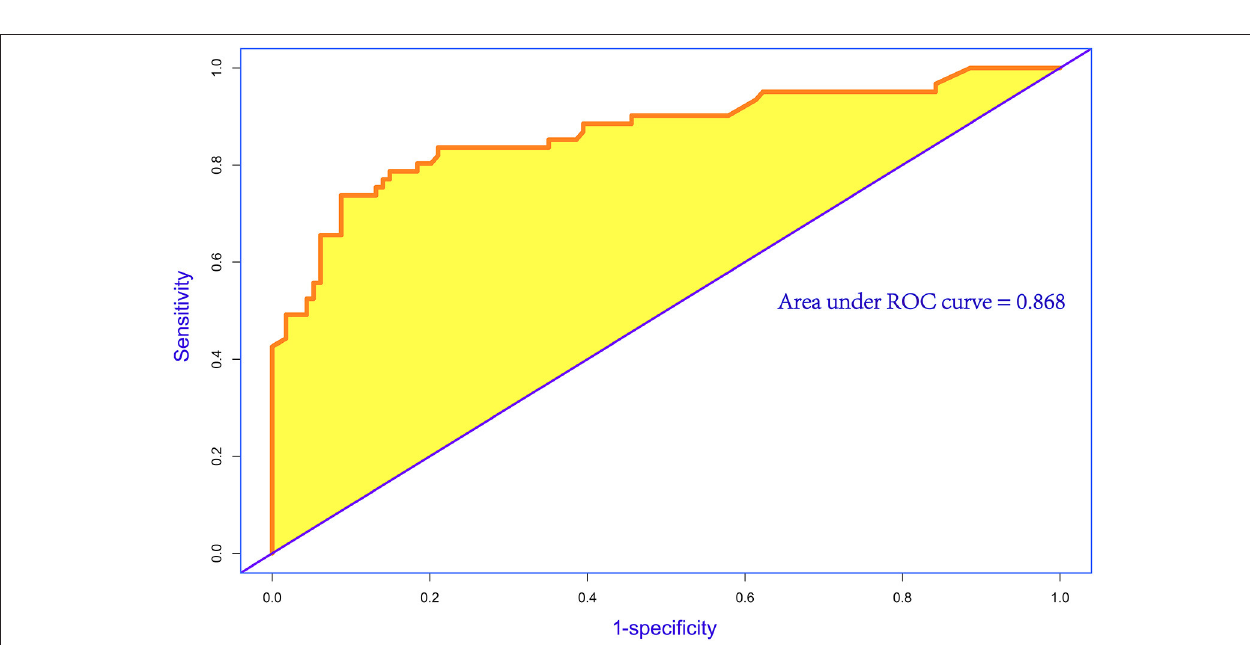
FIGURE 4 | Receiver operating characteristic (ROC) curve for evaluating the discrimination performance of the model. The area under the ROC curve was 0.868 and C statistic was also 0.868. function monitoring and the active use of multiple perioperative brain protection strategies during the perioperative period may improve patients’